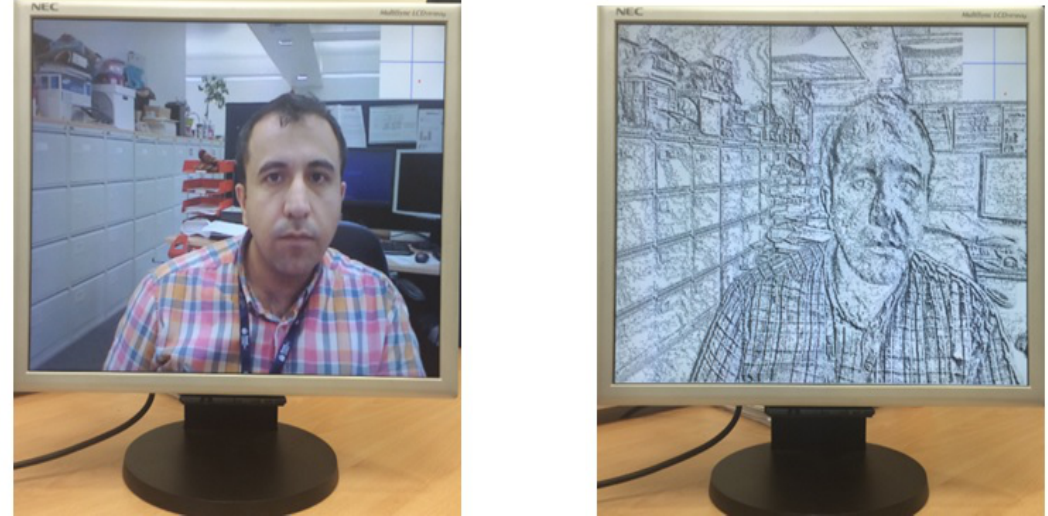
Figure 7. Real-time display of the LBP feature implemented from FPGA hardware.